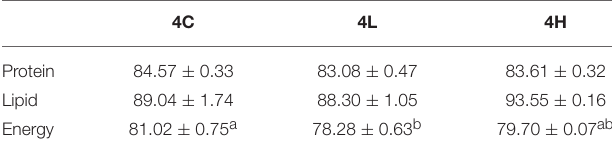
TABLE 4 | Digestibility of the different feeds.